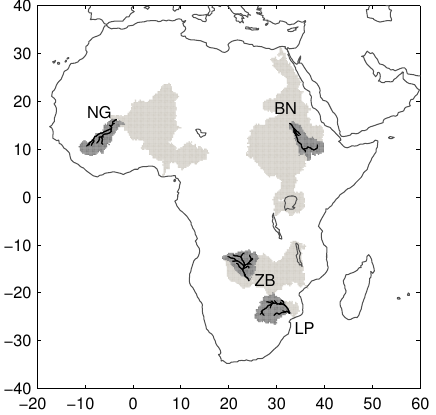
Fig. 1. Basins definition (dark grey), and the full basin (dark and light grey). See also Table 1.